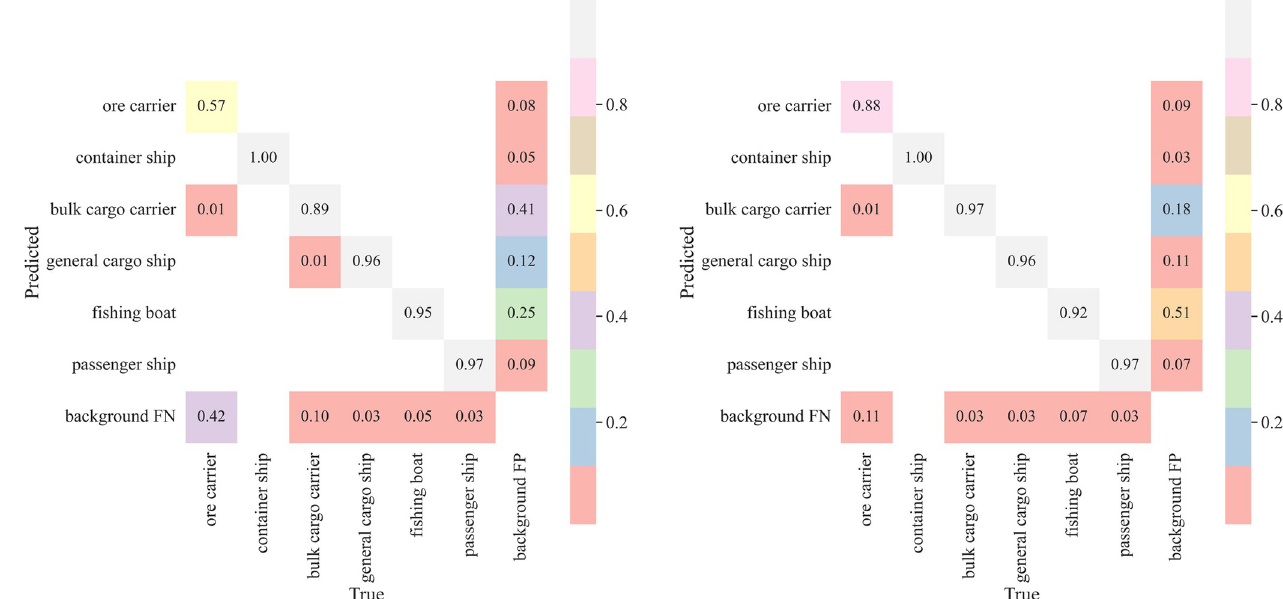
Fig 15. Confusion matrix for different types of ship test sets. (a) YOLOv5s (b) MC-YOLOv5s.